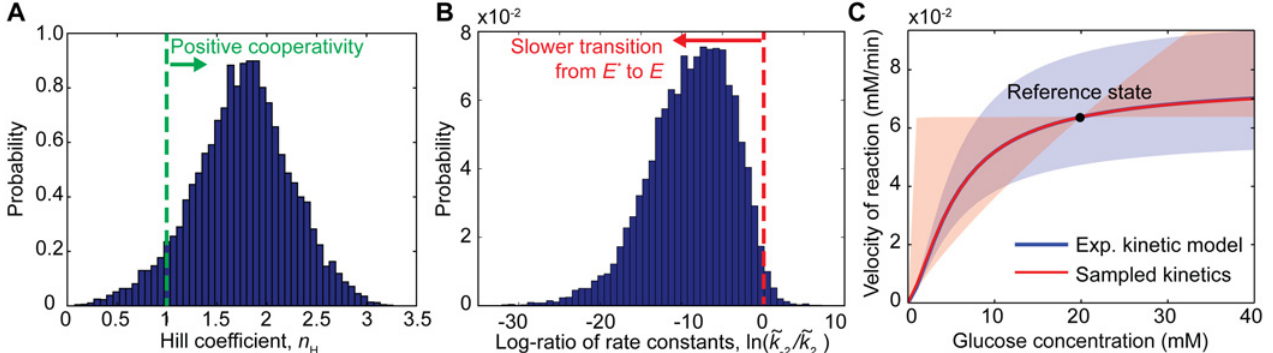
Fig 5. Sampling monomeric cooperativity of mammalian glucokinase. (A) Probability distribution of the Hill coefficient for the glucokinase. Approximately 93% out of 10 4 sampled kinetics displays cooperative behaviour. (B) Probability distribution for the ratio of the forward and reverse rate constants from the low- to the high-affinity enzyme state. The great majority (98.1%) of the models exhibiting positive cooperativity agrees with a slow transition from the low- to the high-affinity enzyme states. (C) Comparison of the kinetic space described by the model developed by Storer and Cornish- Bowden [48] (blue) and the sampled kinetics using the mnemonic model (red). Each line represents the real kinetic behaviour described by the two models, while the shaded areas denote one-standard-deviation confidence regions for each